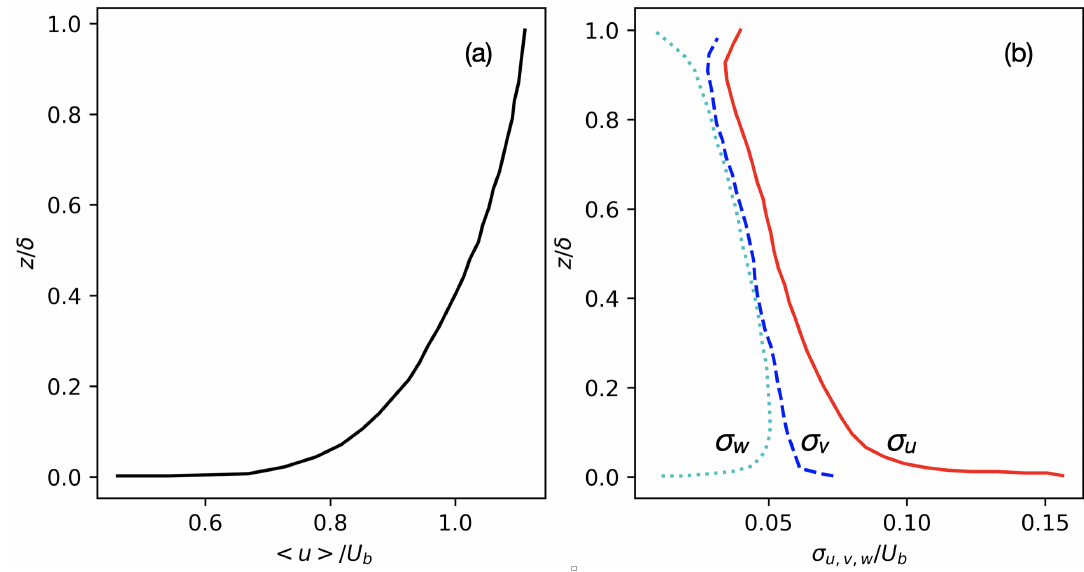
Figure 3. Statistics of inflow employed in the simulation for ( a ) mean downwind velocity and ( b ) standard deviation of velocity fluctuations, where U b is the bulk